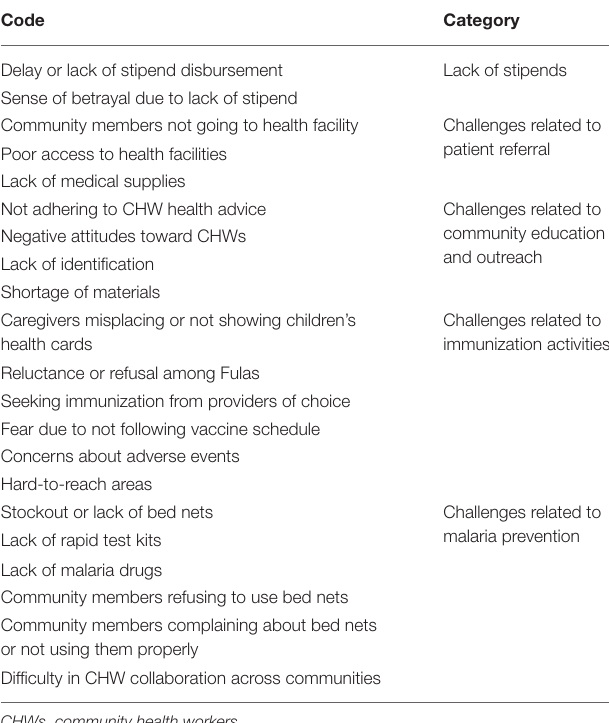
TABLE 2.1 | Codes and categories for Theme 1: “Pride, compassion, recognition, and personal benefits are important motivating factors for CHWs”, qualitative assessment, Western Area Urban, Sierra Leone, 2018.